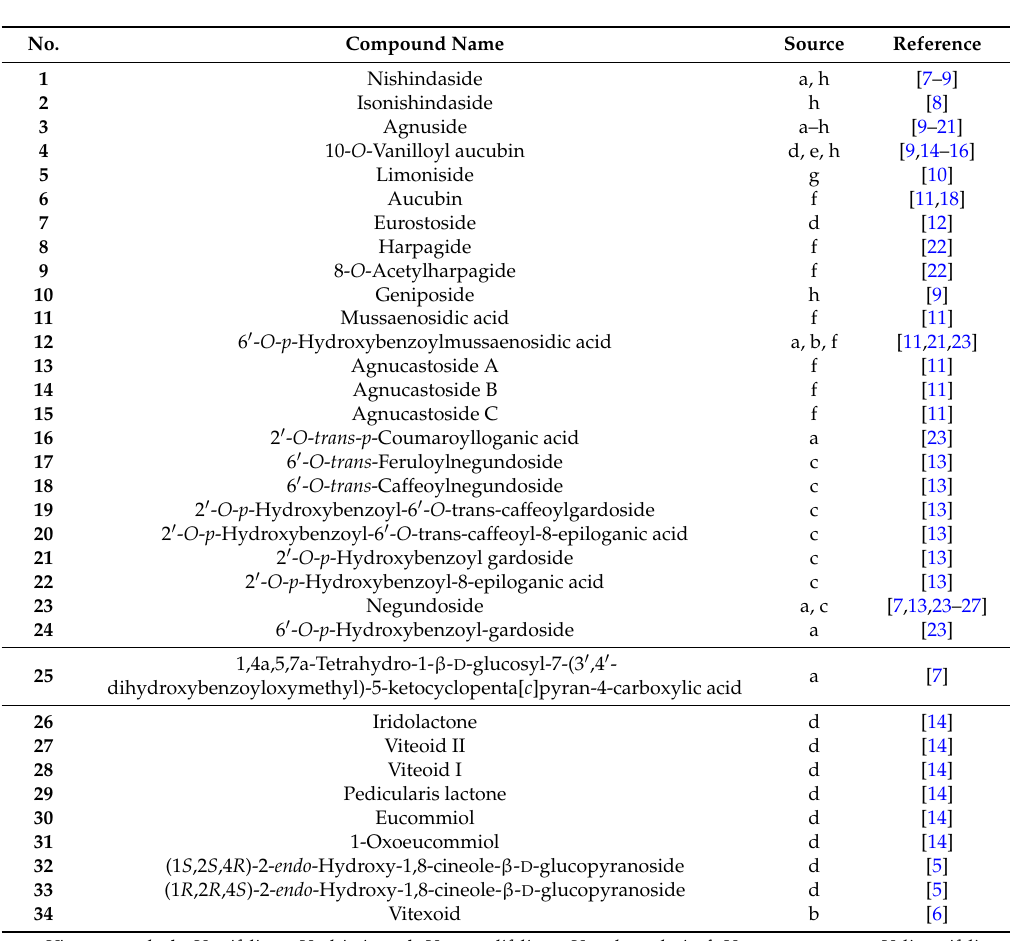
Table 1. Monoterpenoids 1 – 34 isolated from plants of Vitex